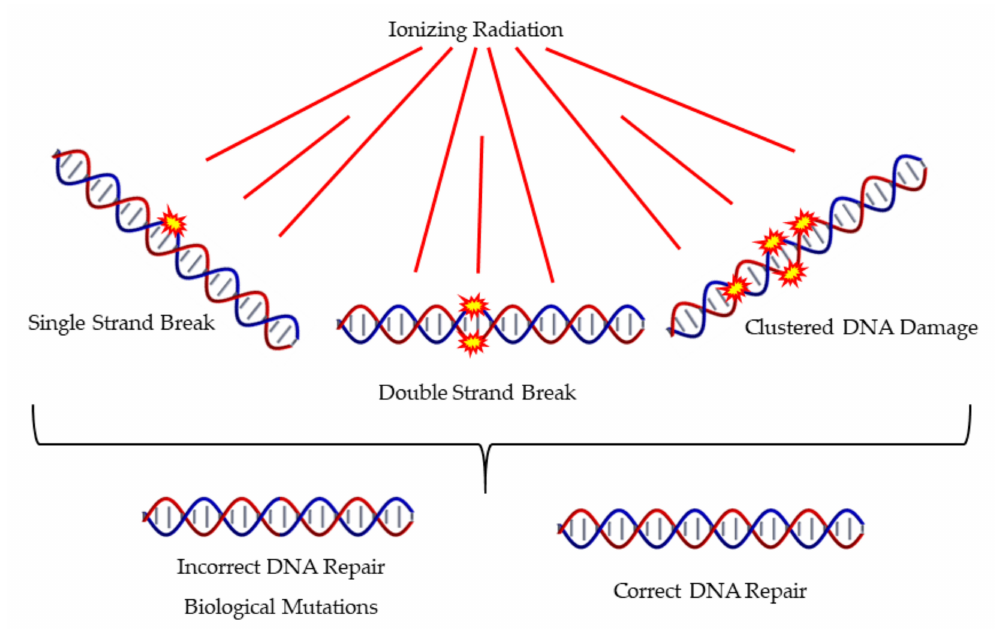
Figure 4. Induction of di ff erent types of DNA damage by ionizing radiation includes single and clustered forms of damage. This may often lead to